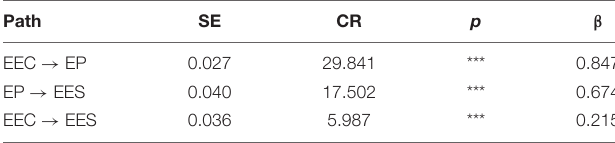
TABLE 6 | Model regression coefficient